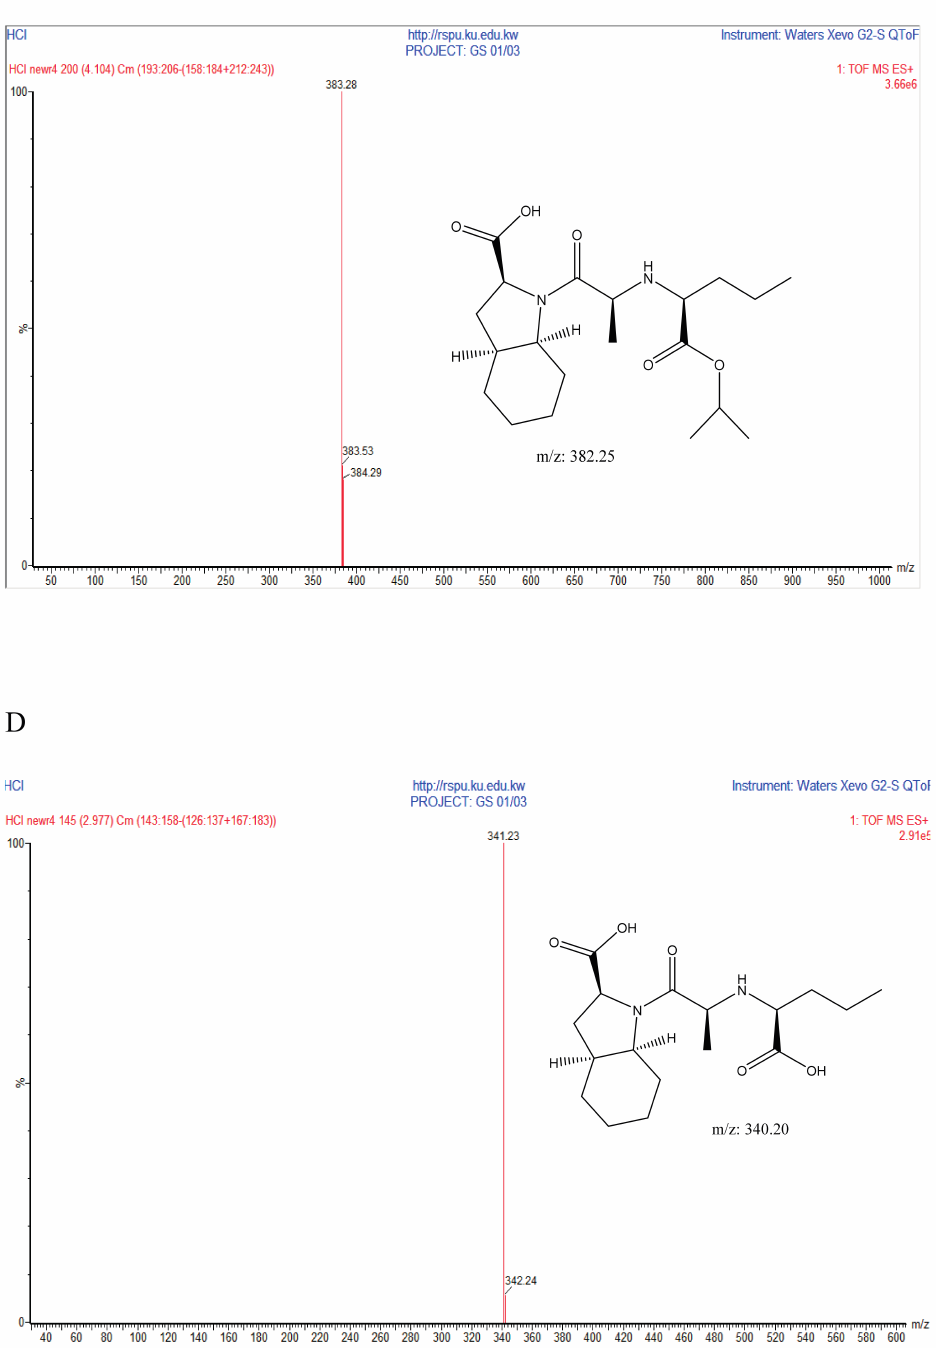
Figure 6. Suggested chemical structures of Perindopril degradants under acidic conditions. ( A ) Degradant A; ( B ) Degradant B; ( C ) Degradant C; ( D ) Degradant D. MS: mass spectrometry; QToF: Quadrupole